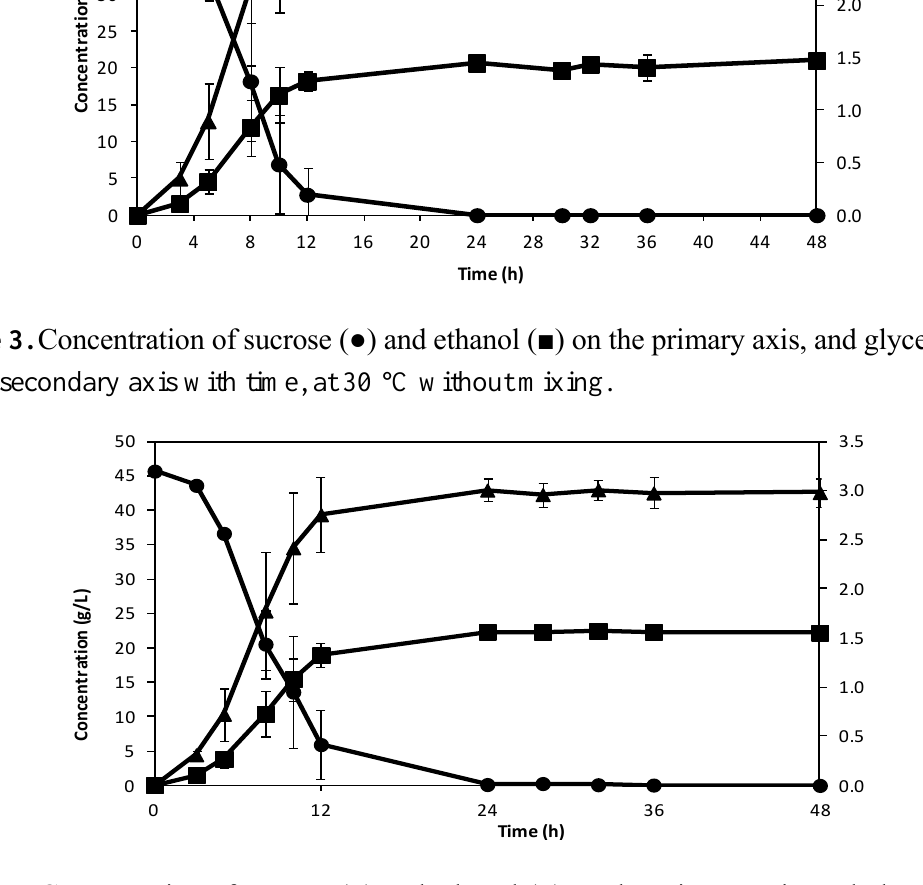
Figure 4. Concentration of sucrose (●) and ethanol (■) on the primary axis, and glycerol (▲) on the secondary axis with time, at room temperature of 22 °C ( a ) with and ( b ) without